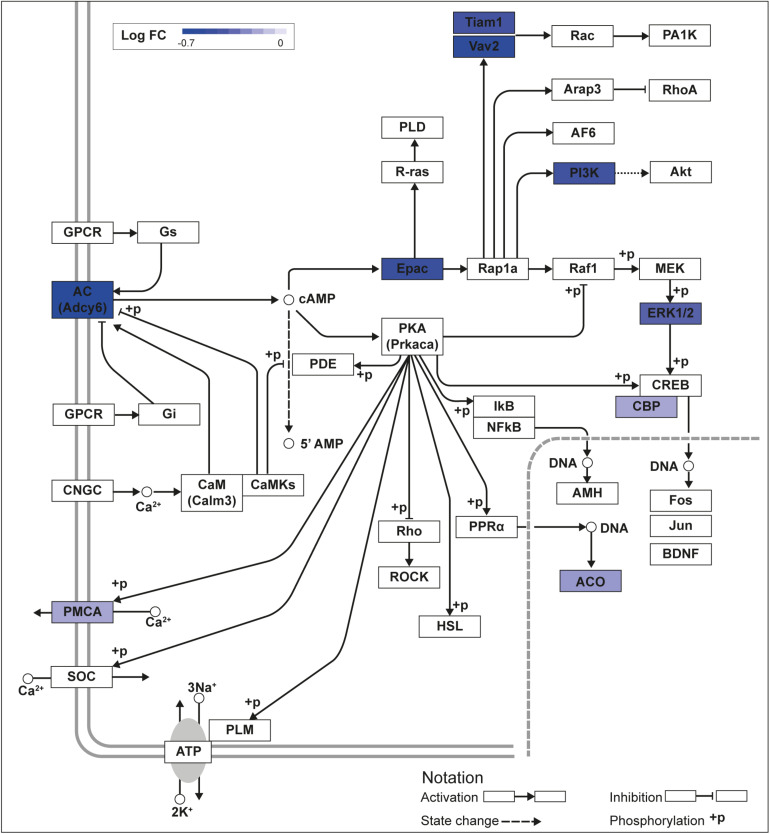
KLF9 regulates cAMP signaling pathway genes in HT22 cells. We previously conducted an RNA sequencing experiment in the HT22-TR/TO-Klf9 cell line treated with or without doxycycline for 8 h to induce the Klf9 transgene (Knoedler et al., 2017). We analyzed differentially regulated genes in the context of the Kyoto Encyclopedia Genes and Genomes signaling pathways. Shown is the core of the cAMP signaling pathway (KEGG:04024) overlayed with differential gene expression values for each gene with a p-value < 0.05. The box shading for each gene represents the direction of change in mRNA levels (Log fold change – Log FC shown in the legend); i.e., boxes with darkest shading indicate the largest decreases in mRNA levels.